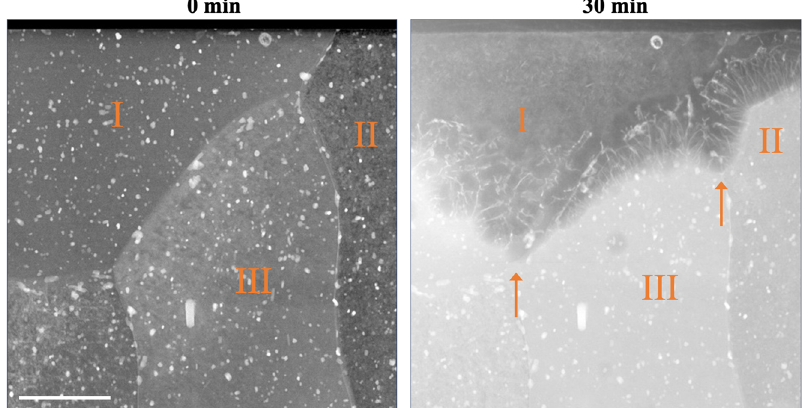
Fig. 4 LP-TEM observations of initial stages of the conversion layer formation in 0.01 M NaCl + 0.01 M Li 2 CO 3 . HAADF-STEM images of a sandwiched lamella before and after 30 min exposure, revealing different electrochemical activity of grain boundaries (orange arrows) and also grains. The images are taken in the absence of the electrolyte. The specimen is approximately 350 nm thin excluding the TEOS layers. The scale bar is 2 μ